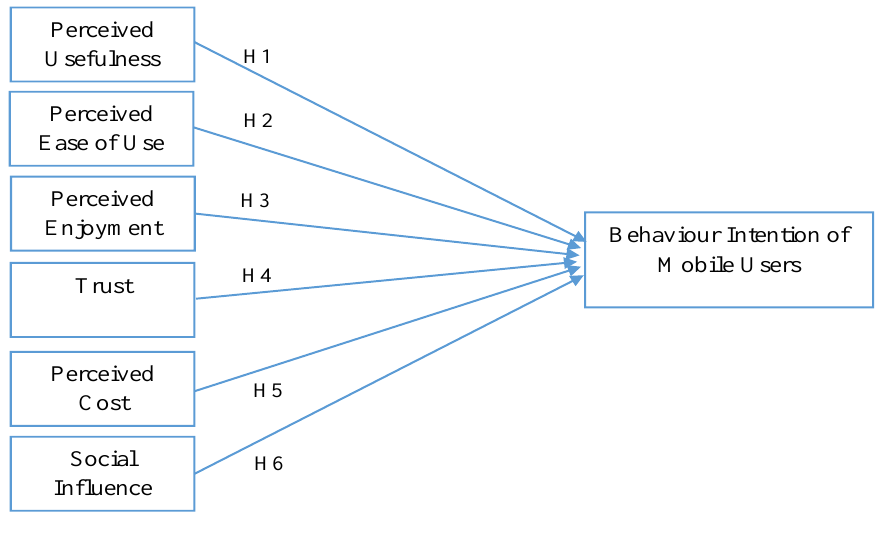
Figure 1. Research